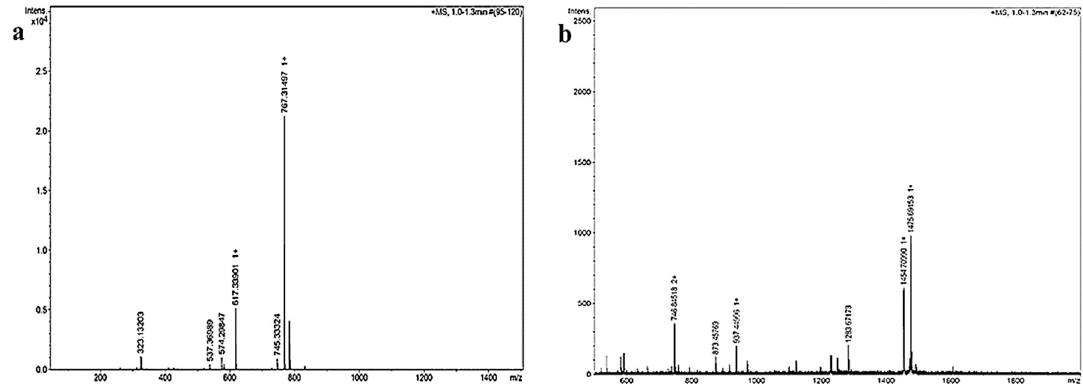
Figure 1. Mass spectra of ( a ) G0K-FP (flurbiprofen) showing a peak at 745.33 represents the exact molecular weight (MW) of product and the highest peak of 767.31 represents the sodium salt. ( b ) G1K-FP showing a peak of 1454.68 representing the exact MW of product and the highest intensity peak of 1475.69 representing the sodium salt in addition to the double charged ion appeared in 746.84 m / z .